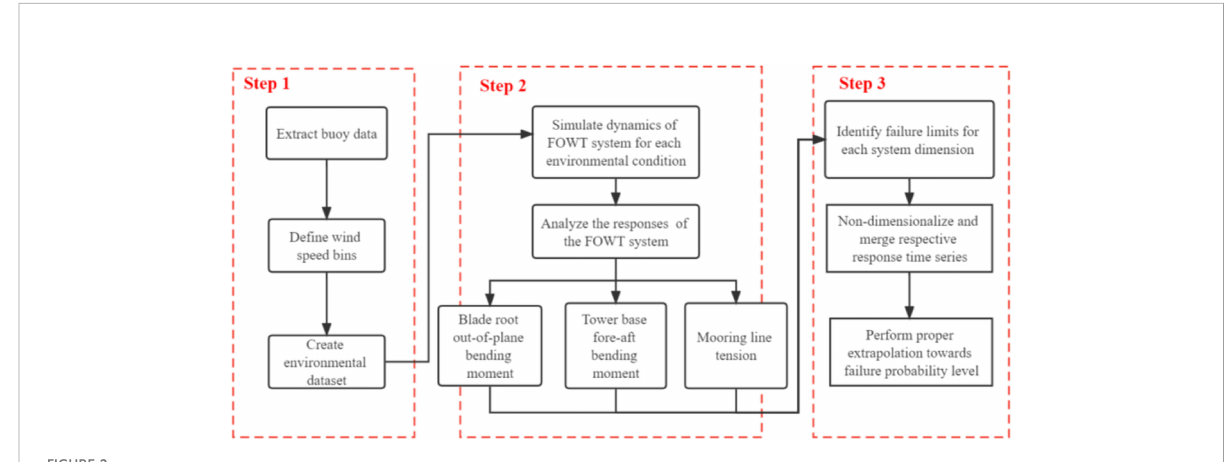
FIGURE 2 Flow chart of the multi-dimensional reliability method.